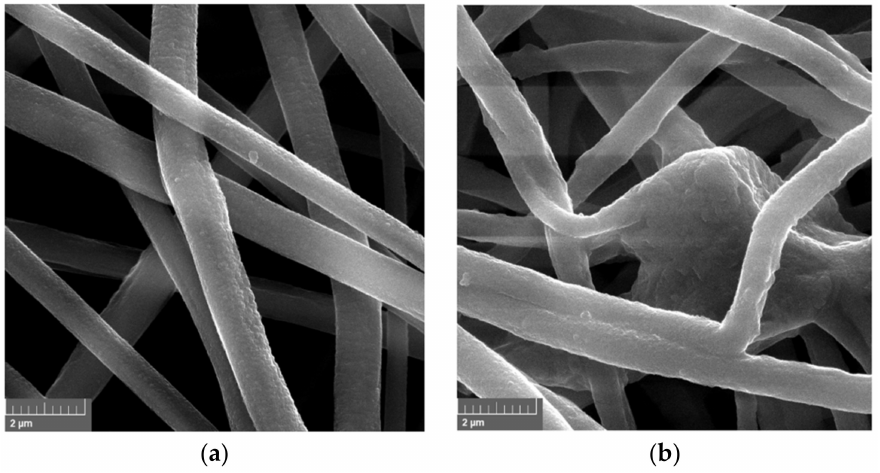
Figure 1. SEM photos of: ( a ) PVC fibers; ( b ) PVC fibers with encapsulated